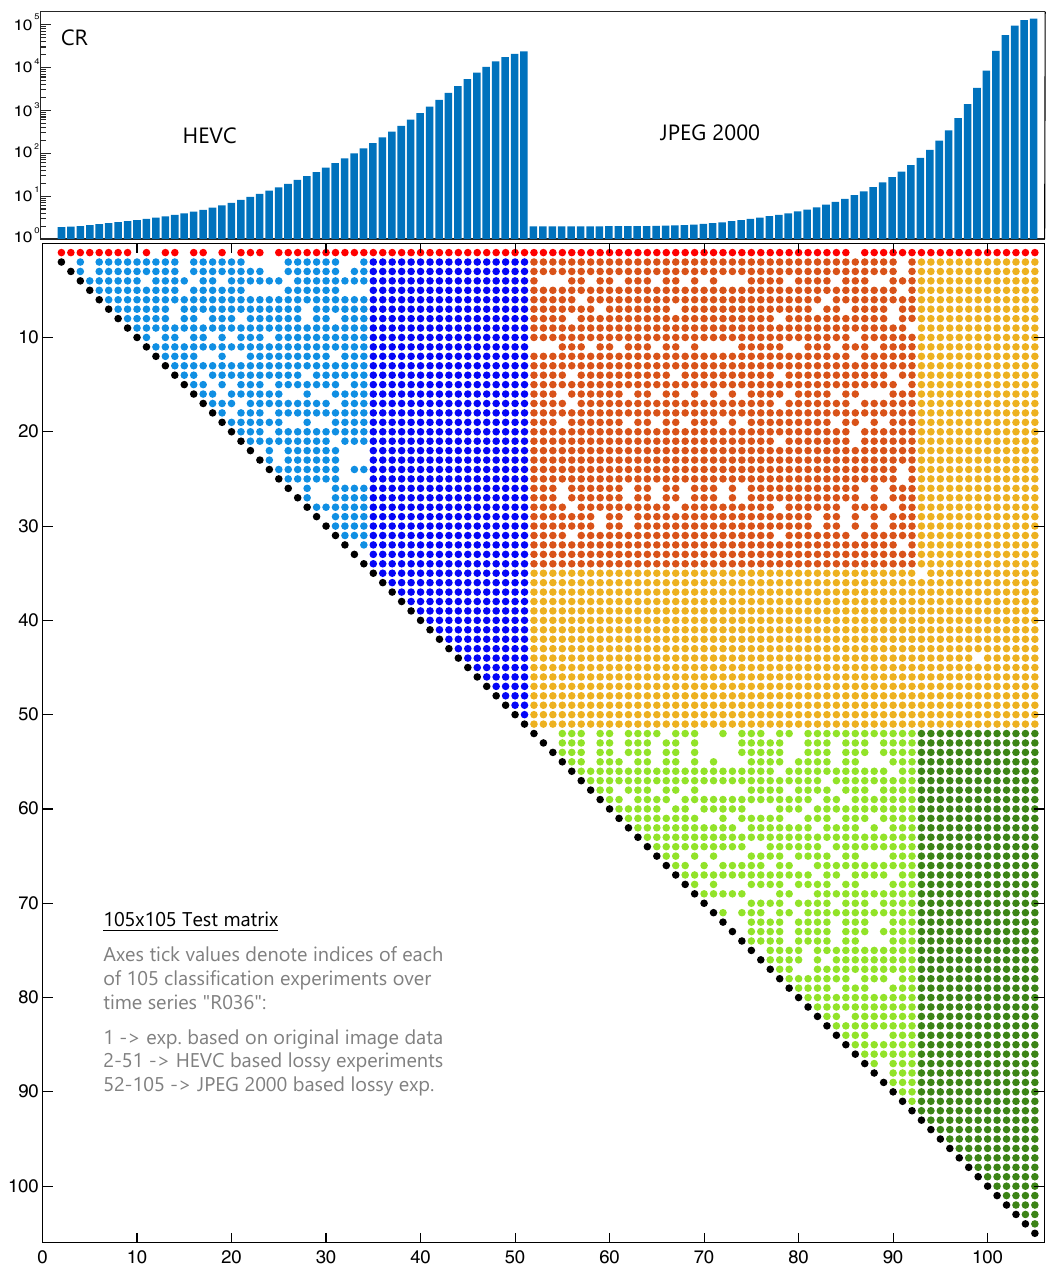
Figure 12. Results of the tests of statistical significance of difference among the classification results produced by the crop thematic mappers based on the HEVC and the JPEG 2000. Missing entries indicate pairs of experiments with non-significant differences. Coloured circles above the main diagonal indicate rejections of the null hypothesis, and denote the pairs of experiments with significantly different classification performance. Tests were based on the Cohen’s Kappa statistic and the significance level of 5%. Black circles on the main diagonal correspond to the tests of all 104 experiments against the classification results expected to be produced by chance, while the circles in red correspond to the tests against original classifier based on the uncompressed image data in the time series R036. Other regions are coloured according to the type of test (exclusively within the HEVC based results, light and dark blue ; or exclusively within the JPEG 2000, the green ones). Orange and yellow regions are the crosswise tests between the HEVC and the JPEG 2000. Aligned above the test matrix is the bar diagram representing compression ratios (CRs) achieved by the each of the experiments. Interpretations of regions illustrated by different colours and discussion of tests implications are given in Section